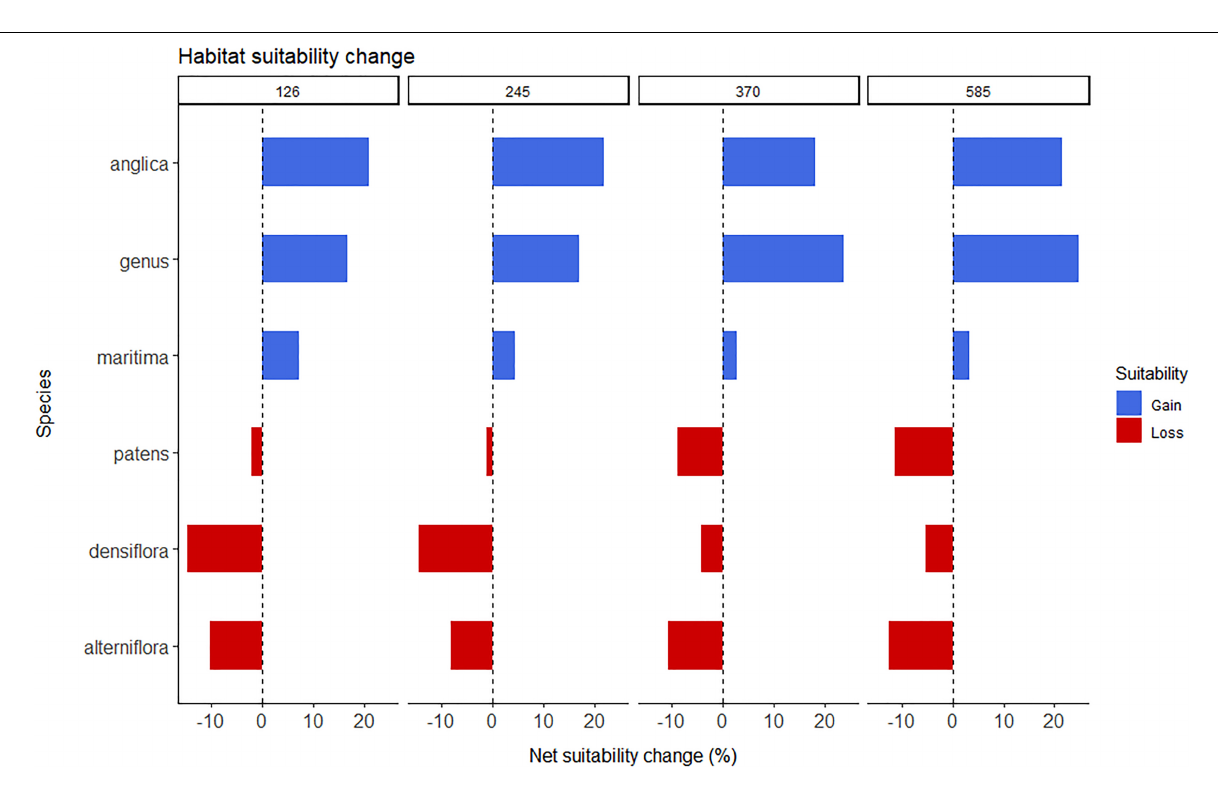
Frontiers in Marine Science |